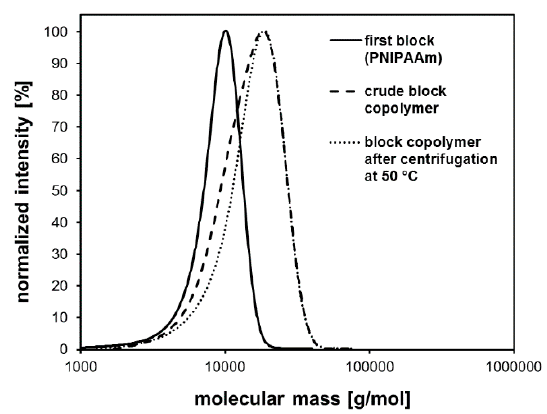
Figure 8. Molecular mass distributions of the first block, the block copolymer before and after centrifugation at 50 °C as a result of SEC analysis (exemplarily for sample BC2). Table 7. Composition, number-averaged molecular mass and polydispersity (PDI) values of the block copolymers after